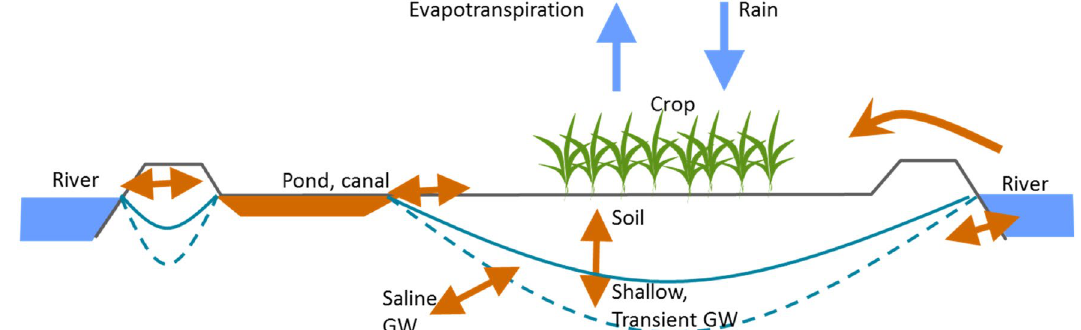
Figure 2. Schematic diagram of key processes governing water and salt balances in a polder. The blue arrows depict the movement of water without salt—rainfall and evapotranspiration. The brown arrows for the movement of water and salt between the rivers, groundwater, surface canals and ponds, and the soil. GW denotes soil and available from capillary rise is insufficient for the crop, water may be transferred for irrigation from the river back to the canals and ponds and from there to the soil. The volume of water for irrigation is limited by the salt concentration of the water in the river and in the canals and ponds, and also by the volume of water stored in the canals and ponds. Finally, water (and salt) may flood the polder in storm surges. Three instances of the model were calibrated by Mainuddin et al. 31 for the three study locations which cover the range of water and salt environments in the delta (Table 1) from high rainfall / low evapotranspiration and low salinity at Amtali, to the lower rainfall/higher evapotranspiration and high salinity at Gosaba 31 . The calibra- tion involved fitting the model to field observations such as canal and pond salinities, soil water salinity, shallow groundwater salinity and groundwater depth and also to the results of a 24-year time-series of crop water use and soil water and salt balance simulations using an independently validated APSIM ( A gricultural P roduction S ystems s IM ulator 56 ) crop model. The latter comparison allowed the polder water and salt balance model to be calibrated to a longer time-series of results, and also tested parts of the model not directly addressed by calibration to the field results. The calibration of the polder water and salt balance model used one set of parameters at each site for both the comparison with the field measurements and the comparison with the APSIM model results. A sensitivity analysis on the model was also performed using a Monte-Carlo simulation. The results shows that